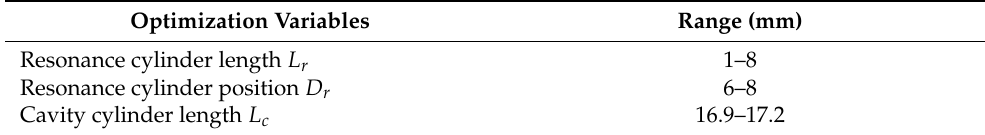
Table 2. Range of optimization variables.